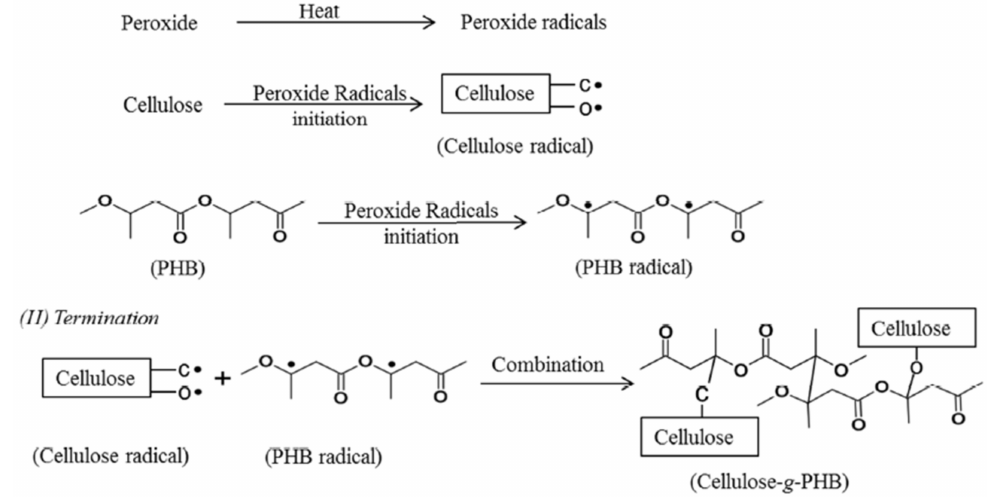
Figure 3. The general mechanism of peroxide radical initiated grafting of polyhydroxybutyrate (PHB) onto cellulose (reproduced with copyright permission from Wei et al.